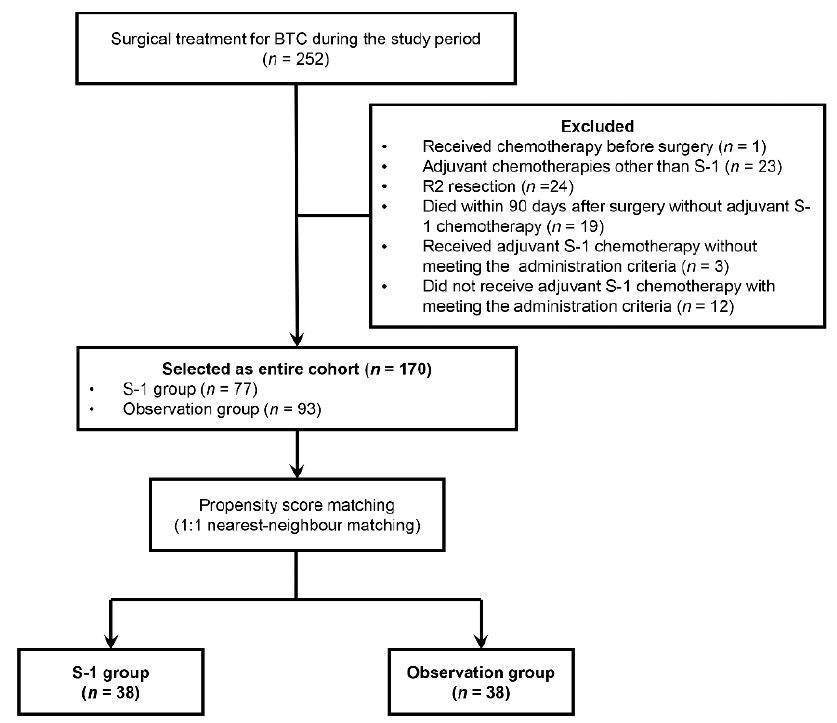
Figure 1. Flow chart of the patients included the study. Table 1. Profiles and tumour characteristics of the patients in each group of the entire